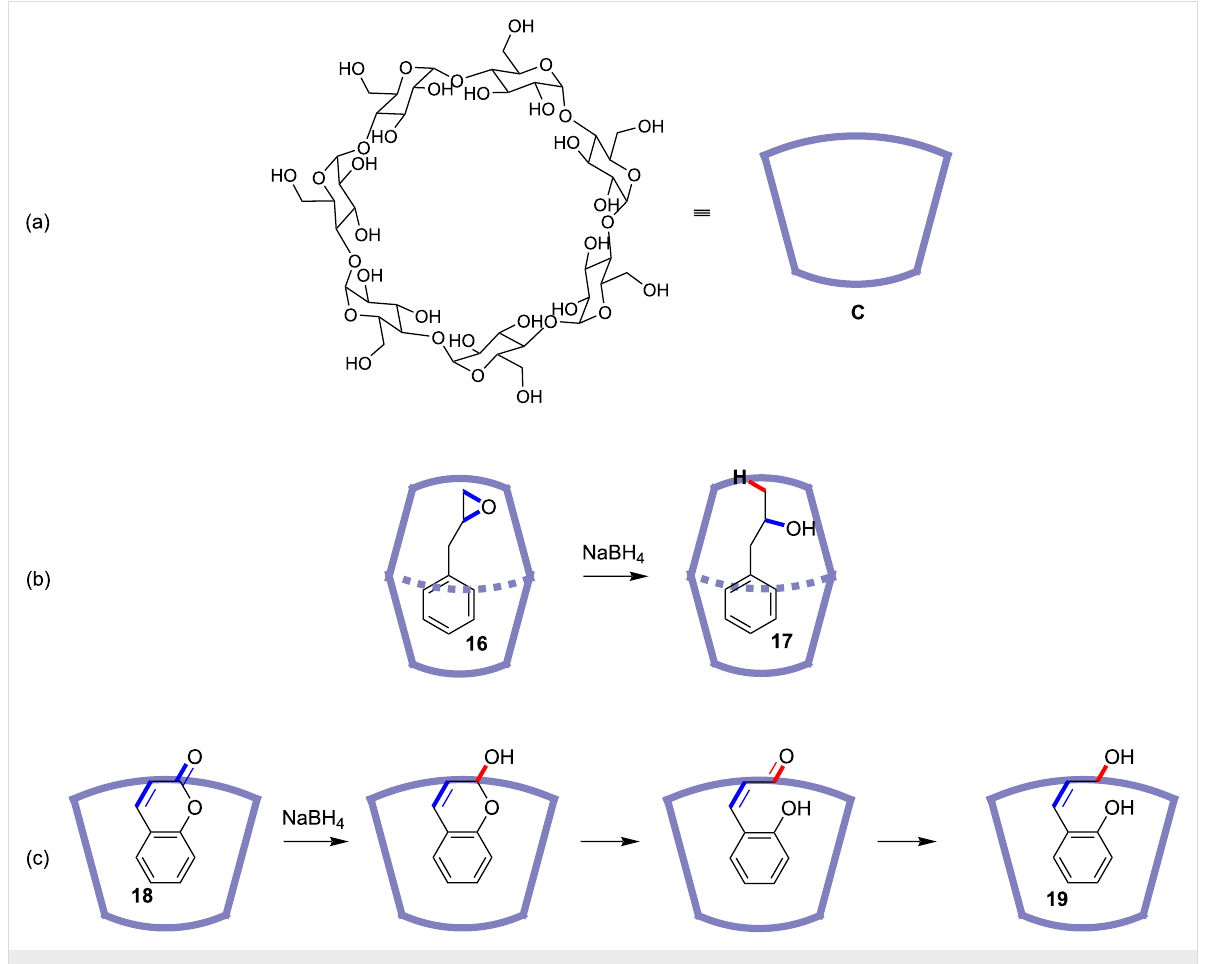
Figure 4: Cyclodextrin-mediated site-selective